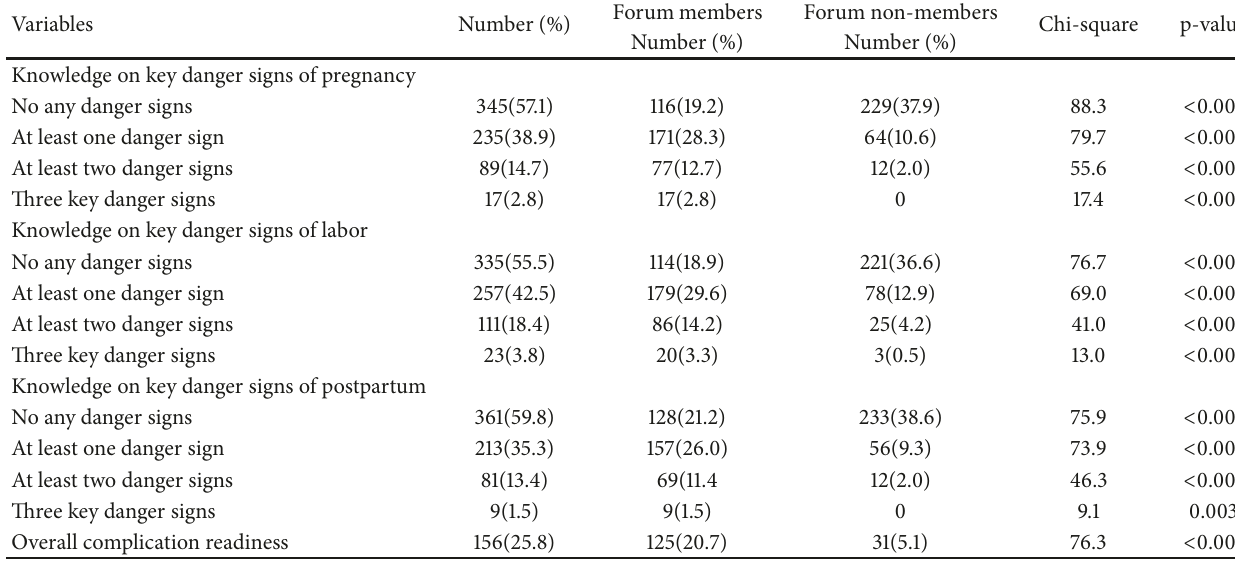
Table 4: Comprehensive knowledge of obstetric danger signs among pregnant women in Dale Woreda, Sidama Zone, SNNPR, Ethiopia, 2015.